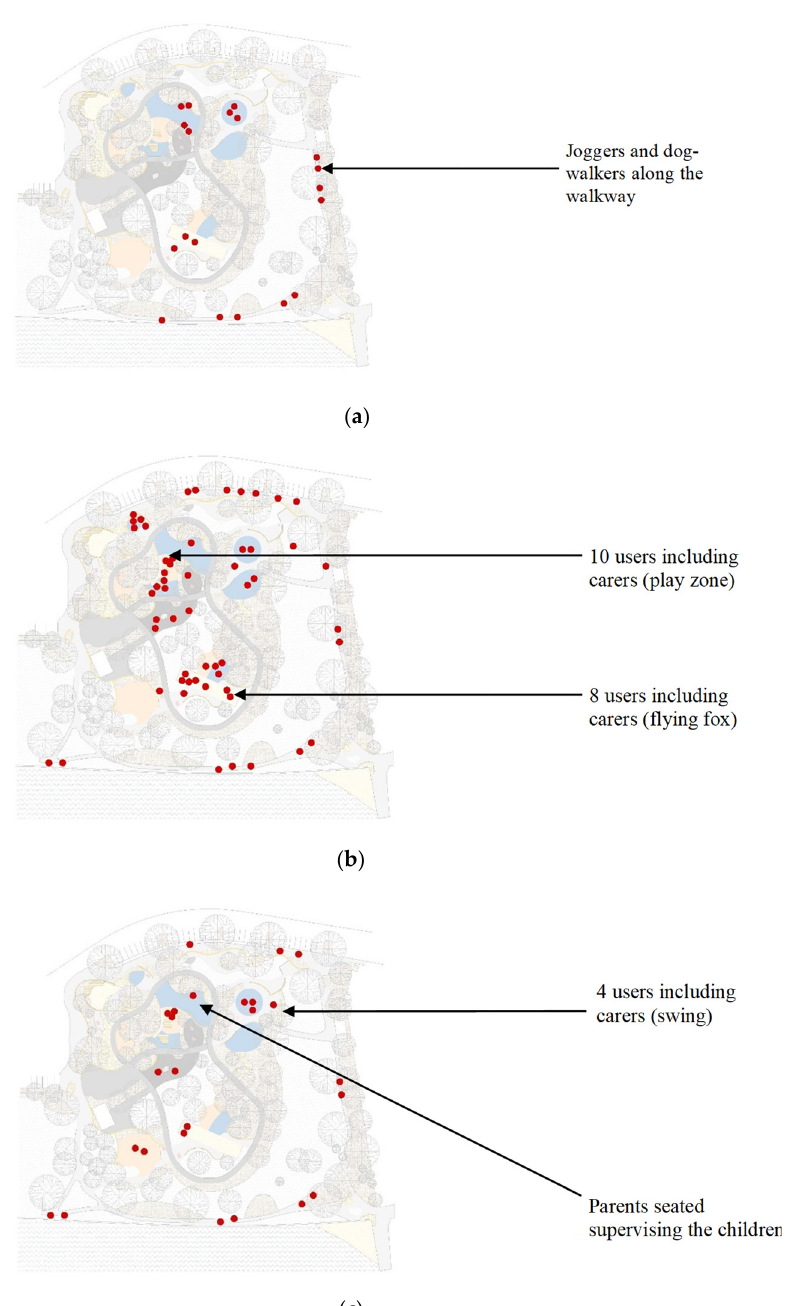
Figure 11. ( a ) Visit 1, ( b ) Visit 2, ( c ) Visit 3. Table 6. Analysis data.